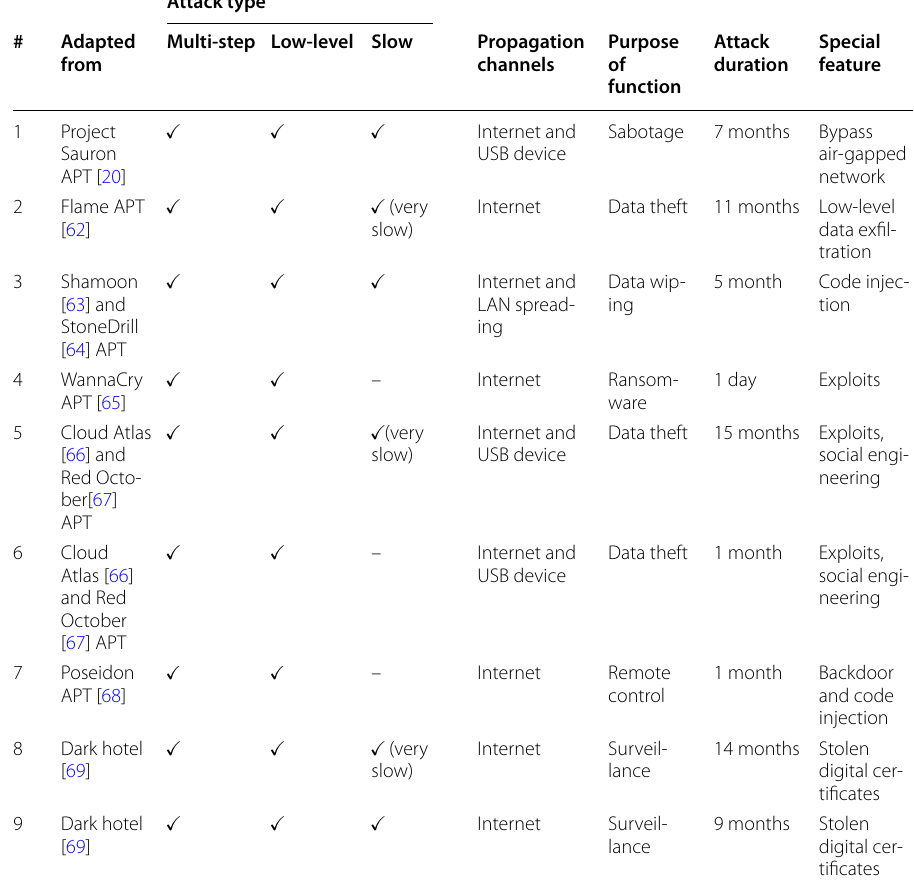
Table 11 APT scenarios in generated dataset Attack